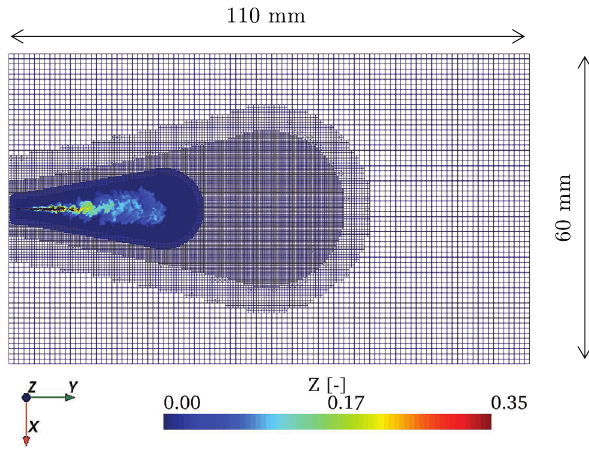
Fig. 3. Computational mesh discretizing the gas phase colored by the solution of the Favre- fi ltered mixture fraction fi eld at 0.40 ms after start of injection. Black dots denote parcel discretizing the liquid phase.